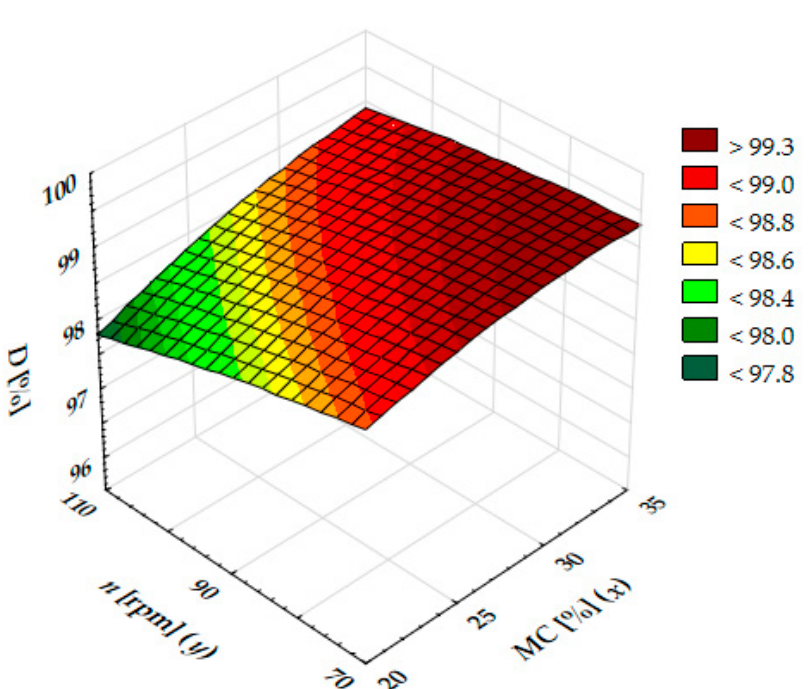
Figure 7. Influence of the rotational speed of the extruder screw and the level of raw material moisture on the durability of the extrudate.